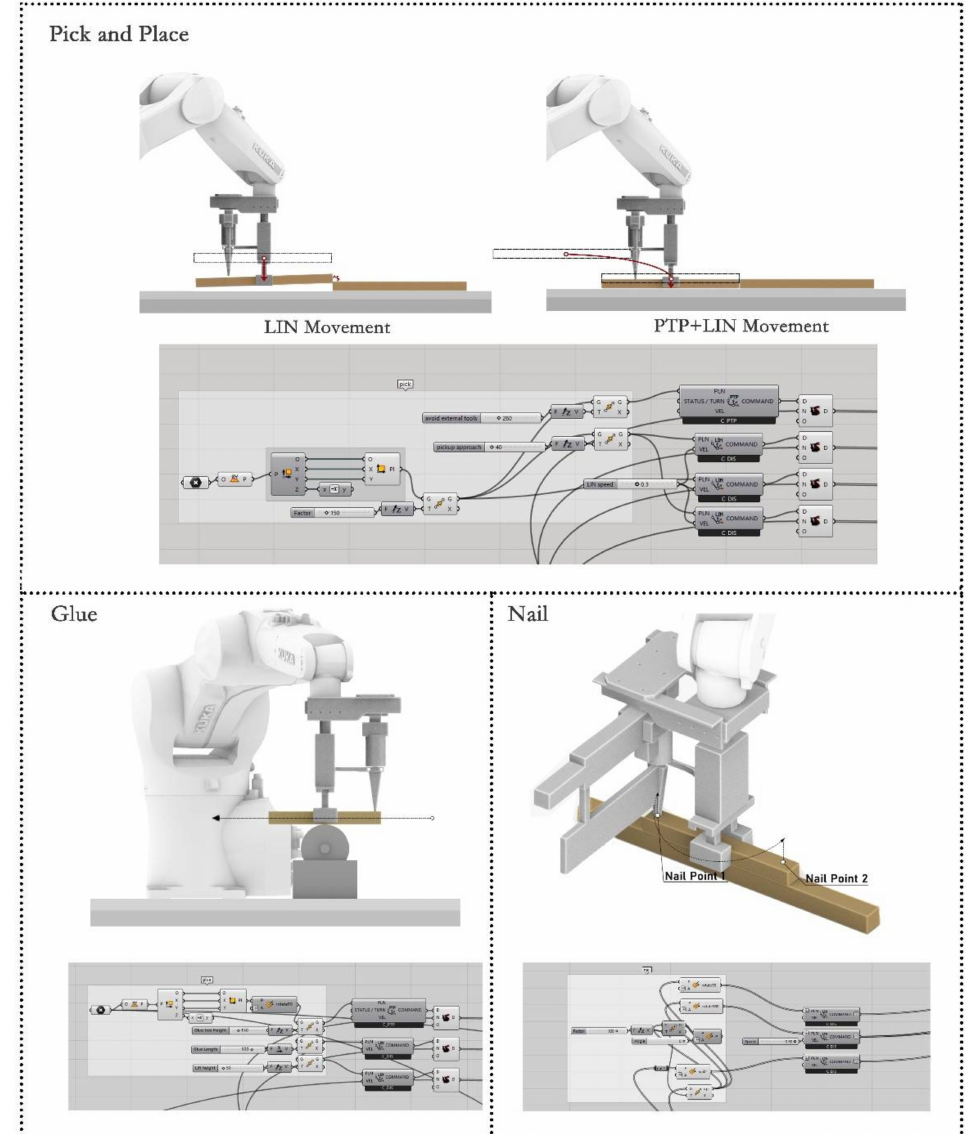
Figure 9. Robotic construction steps: glue, nail, pick, and